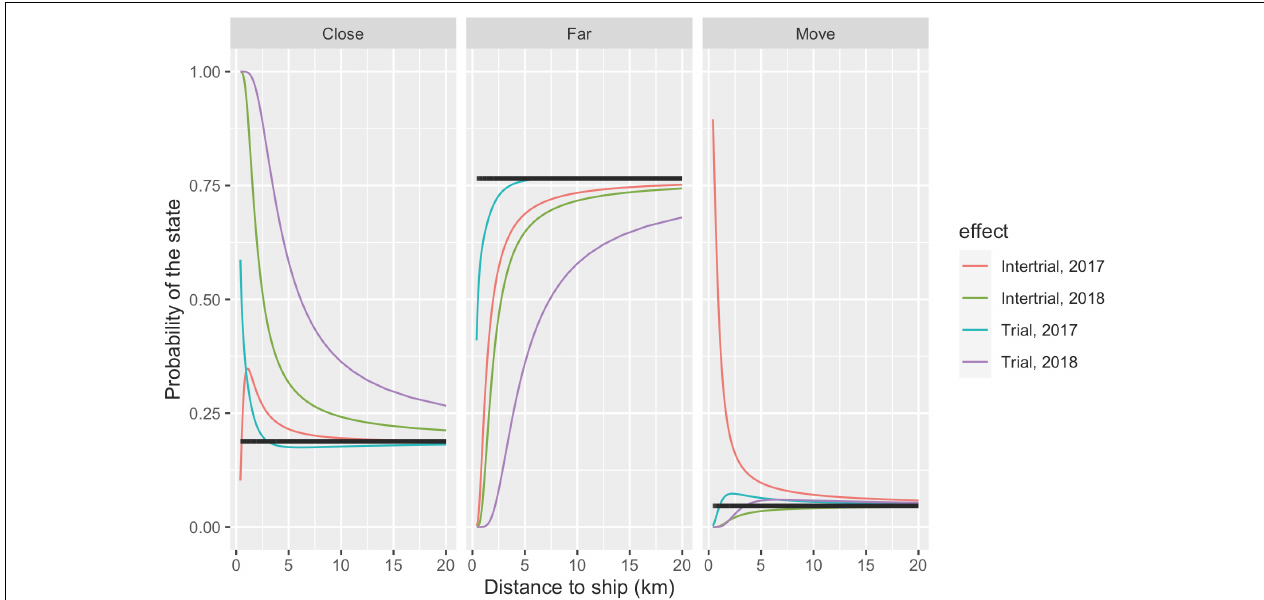
FIGURE 11 | The three probabilities (Close, Far, and Move) as a function of distance to ship under trials (seismic activity, blue and pink curves for 2017 and 2018, respectively) and intertrials (presence of ship, red and green curves for 2017 and 2018, respectively). When the distance to ship goes to infinity (corresponding to no presence of ship), the distribution converges to the distribution under normal behavior; that is, the stationary distribution without exposure indicated by black lines. This distribution is Far = 0.760, Move = 0.049, and Close = 0.191 for the 235-m threshold between the states Far and Close. For example, at 20 km, there is still a considerable effect of exposure during trials in 2018, whereas for exposures in 2017, the undisturbed level is reached at a distance of 20 km. Note that the three curves of the same color in the three panels add to one.